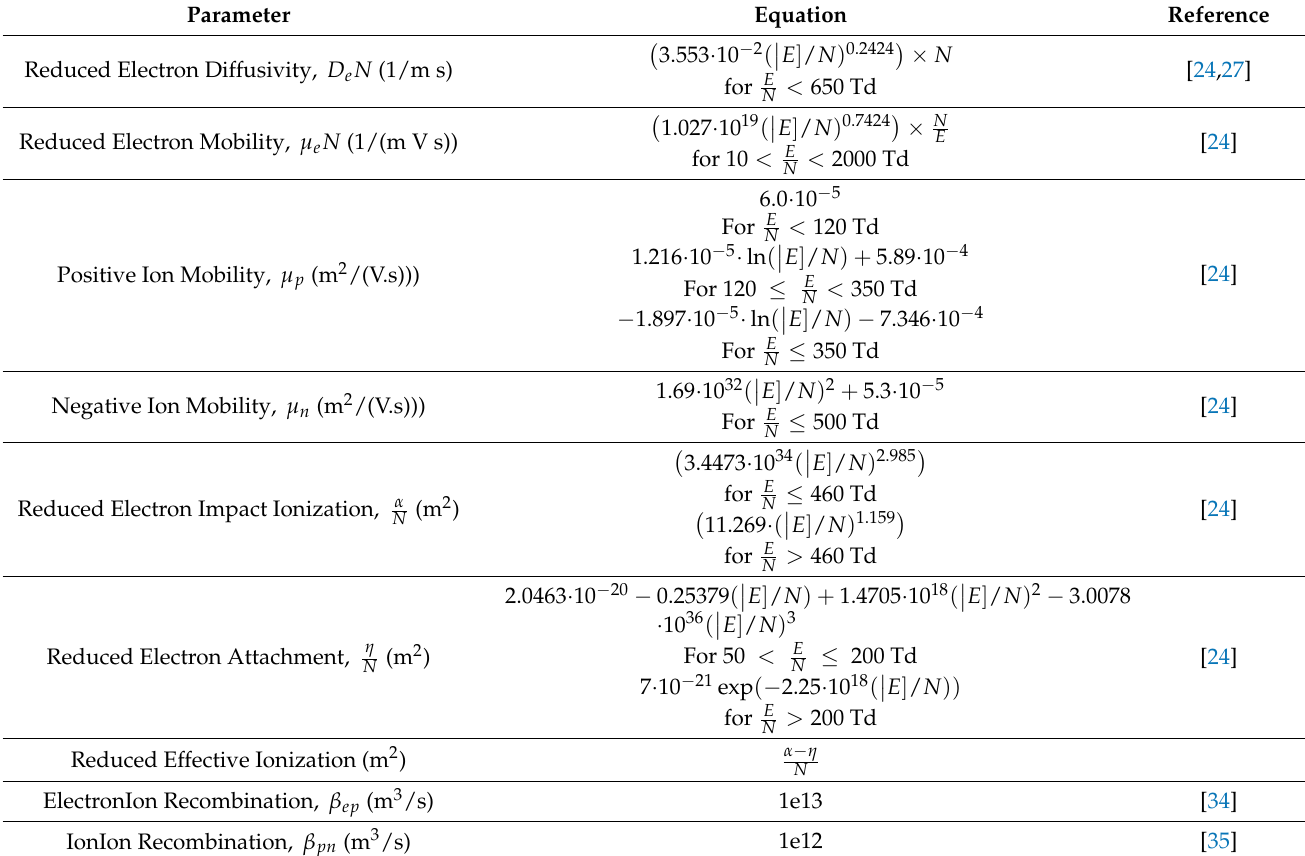
Table A2. Swarm parameters.